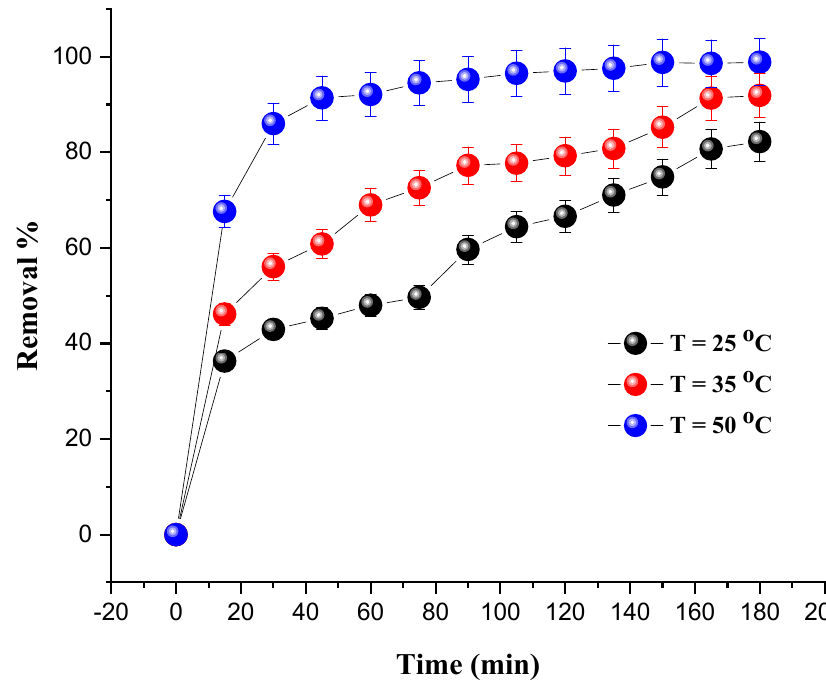
Figure 8. Effect of temperature on MG removal. Reaction conditions: C 0 = 20 mg/L, V H2O2 = 10 mL, pH = 7 and m = 0.8 g.